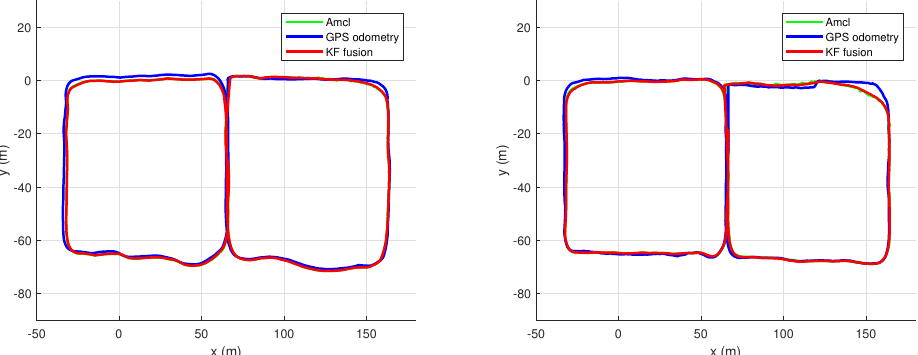
Figure 15. Trajectories through the R 2 path expressed by localization using the fusion described in Section 5. ( left ) Using GNSS standalone. ( right ) Using GNSS floating point. In both cases, the loop closure of the right quadrant is performed off-map. We see that thanks to the fusion of GNSS, we can maintain the trajectory to re-enter the map